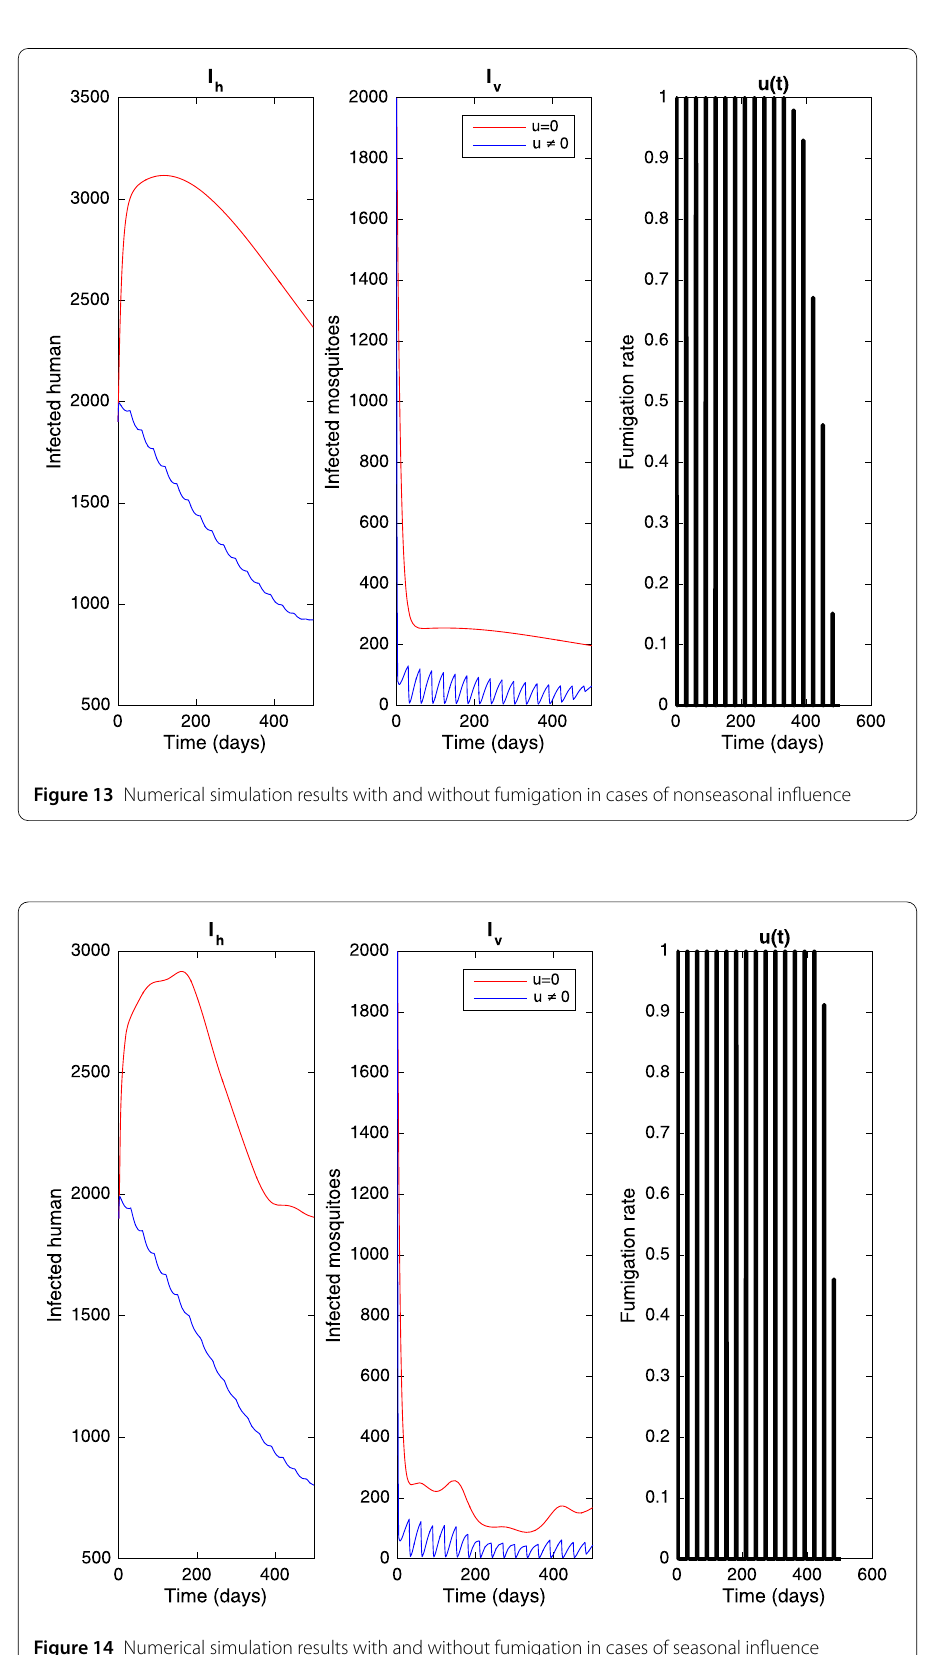
Figure 14 Numerical simulation results with and without fumigation in cases of seasonal